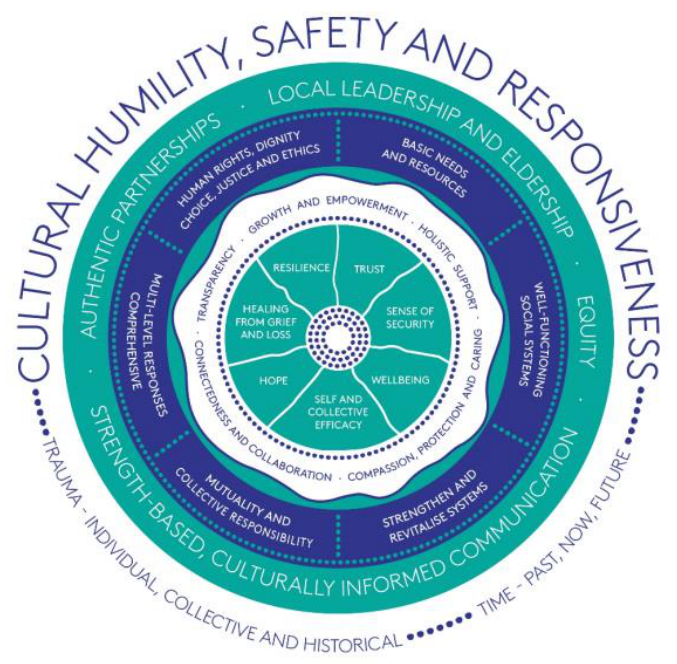
Figure 2. A culturally responsive trauma-informed public health emergency framework for Aborigi- nal and Torres Strait Islander communities.